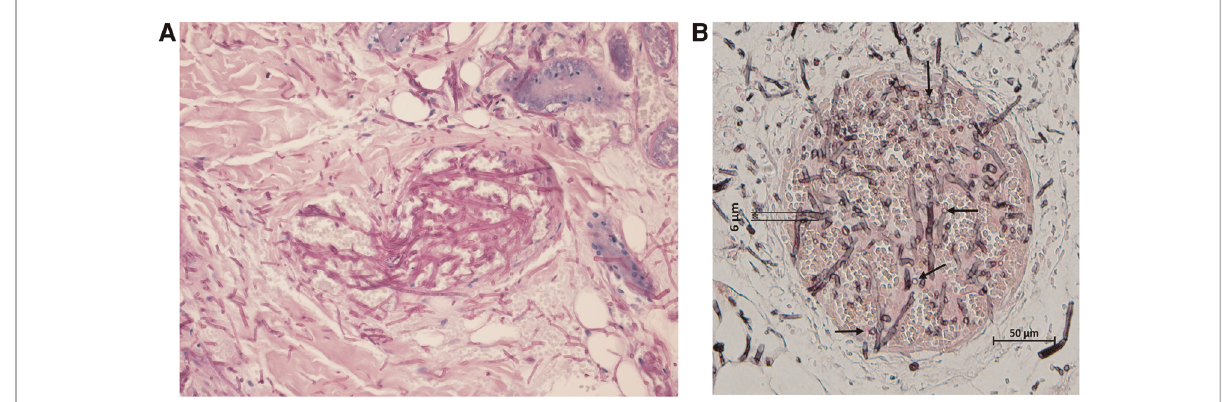
FIGURE 1 ( A ) Microscopic image of a skin lesion. Histologic examination of a skin biopsy following periodic acid – Schiff (PAS) staining shows the extravasation of hyphae from a blood vessel into the surrounding tissue. It is important to note that there is not any reaction of the cellular immune system against this fungal invasion. ( B ) Tissue biopsy of the cutaneous lesion showing vascular invasion and infarction by small, septated hyphae intermingled with chlamydoconidiae (indicated by the arrows) stained by Grocott ’ s methenamine silver stain (magni fi cation 10x), both day +17. Both images were obtained from the same FFPE (formalin- fi xed paraf fi n embedded)